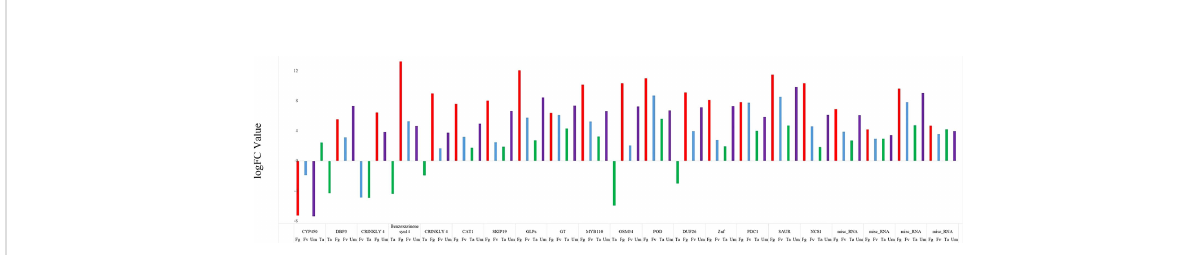
FIGURE 7 Illustration of differentially expressed genes of common genes of four fungal infections. F. graminearum (Fg), U. maydis (Um), F. verticillioides (Fv), and T. atroviride (Ta) are designated as red, purple, blue, and green,